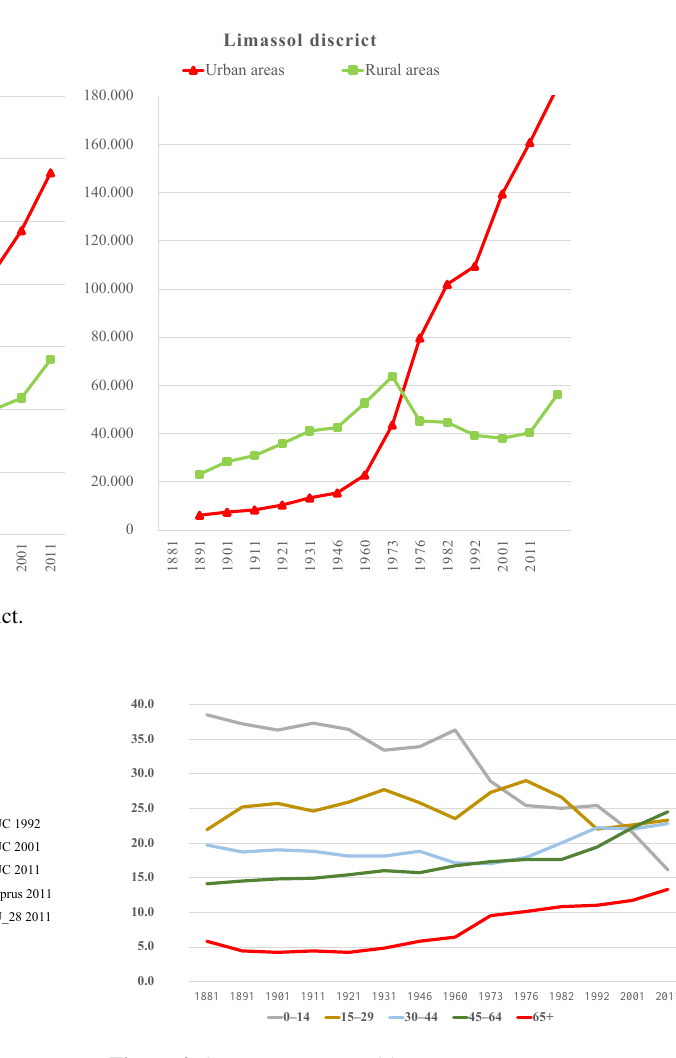
ages 30–44 and 45–64 that consist the active working period (from 17.9 and 17.6 % to 22.8 and 24.5 % respectively), re- flecting the dynamic of the Cypriot population